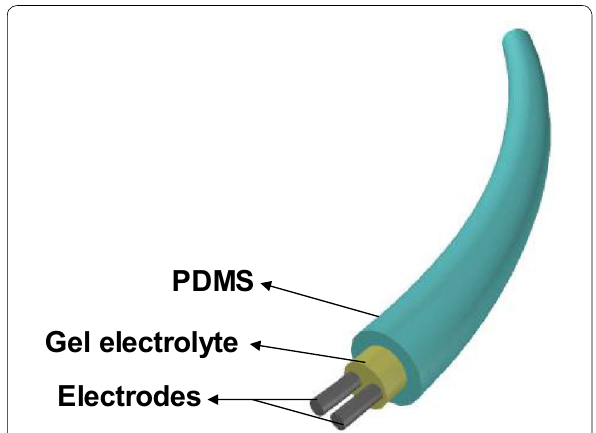
Fig. 1 Schematic diagram of the proposed flexible cable-shaped